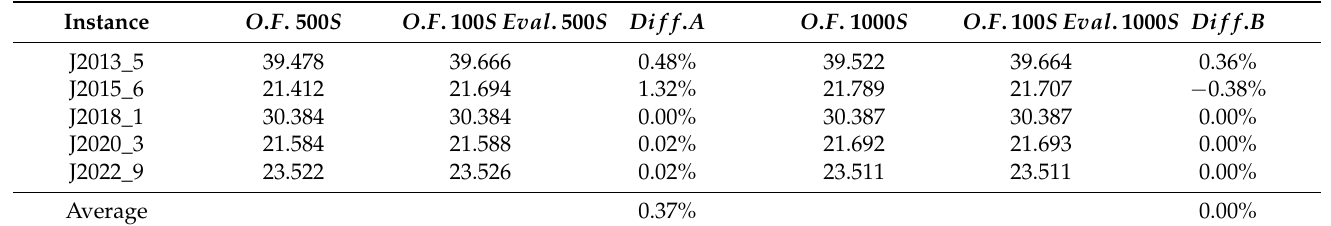
Table 16. Experiment 4 results. Evaluation of the 100 scenarios solution in the 500 and 1000 scenarios. Twenty activities instances.